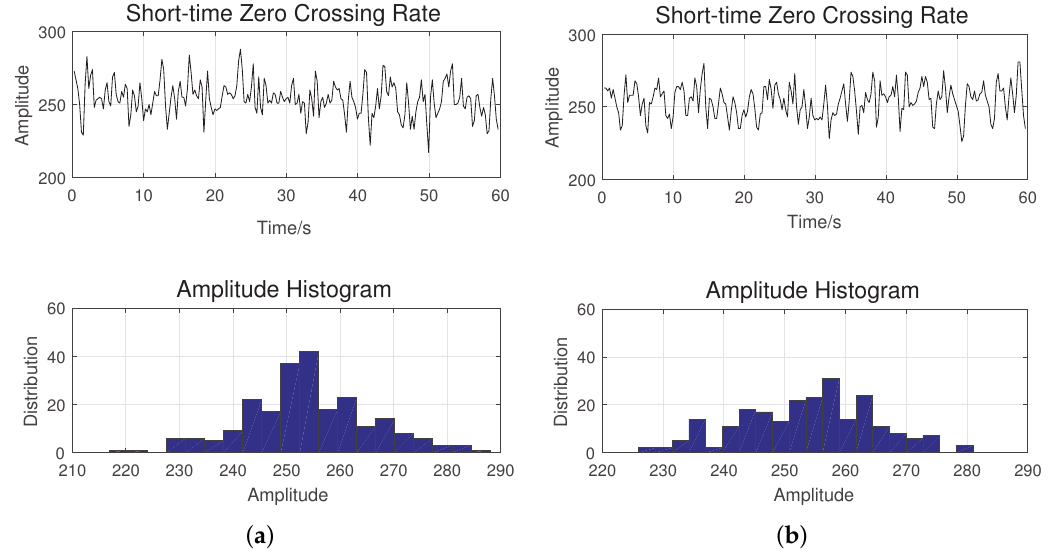
Figure 3. ( a ) Short time zero-crossing rate of the sea clutter; ( b ) short time zero-crossing rate of the land